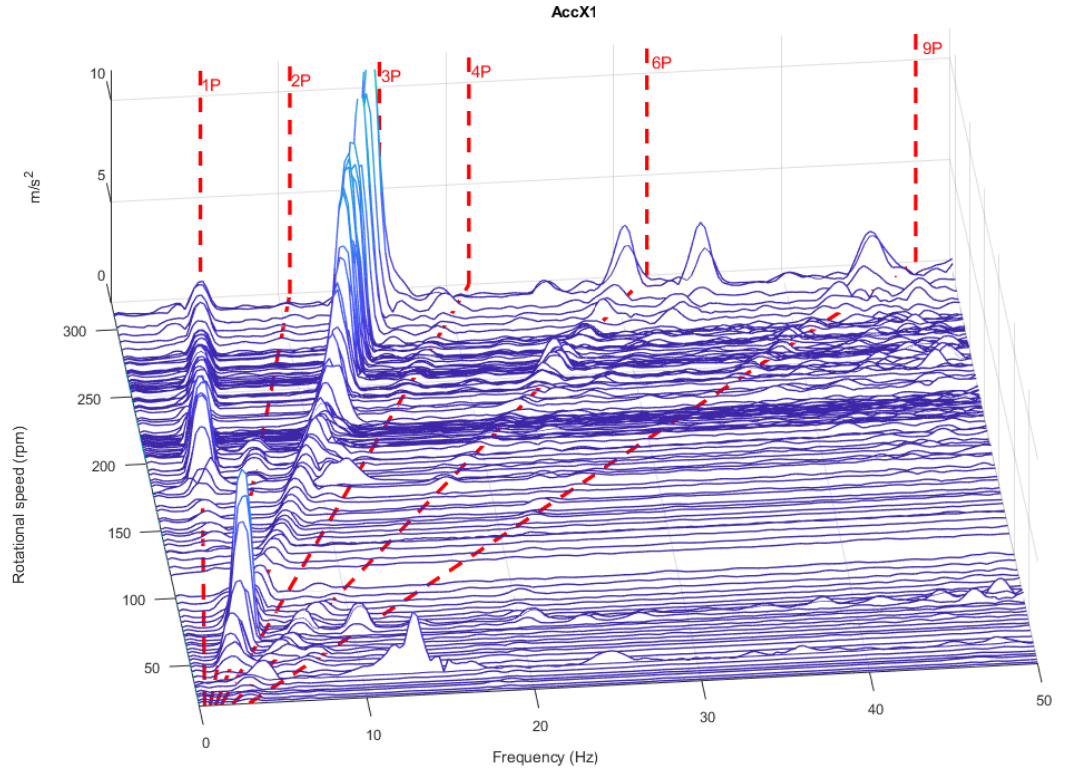
Figure 8. Waterplot of accelerations in x direction on layer